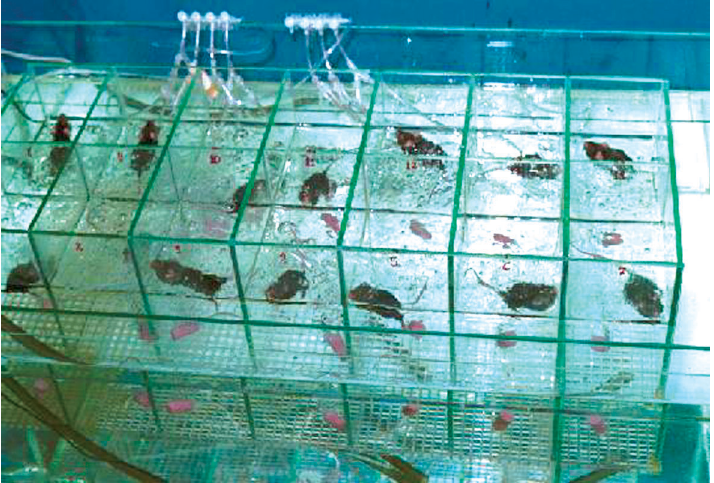
Figure 1. Swimming apparatus for mouse physical